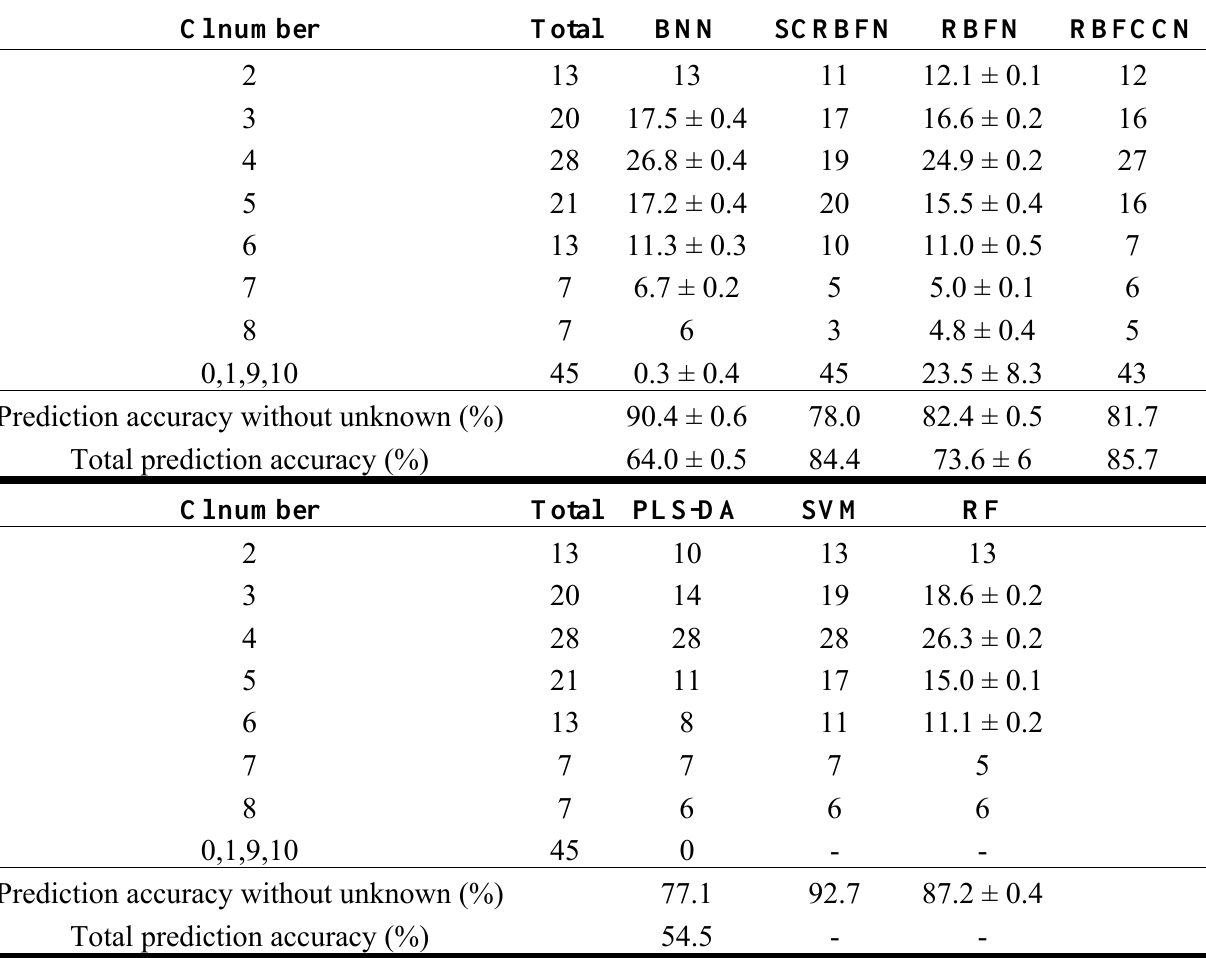
Table 9. Average numbers of correctly predicted spectra with 95% confidence intervals of PCB external validation data set. All modeling methods were reconstructed 30 times. The prediction accuracy without unknown is the prediction accuracy calculated by the external validation set excluding the congeners that contain 0, 1, 9 and 10 chlorine atoms. The total prediction accuracy is the prediction accuracy calculated by the complete external validation